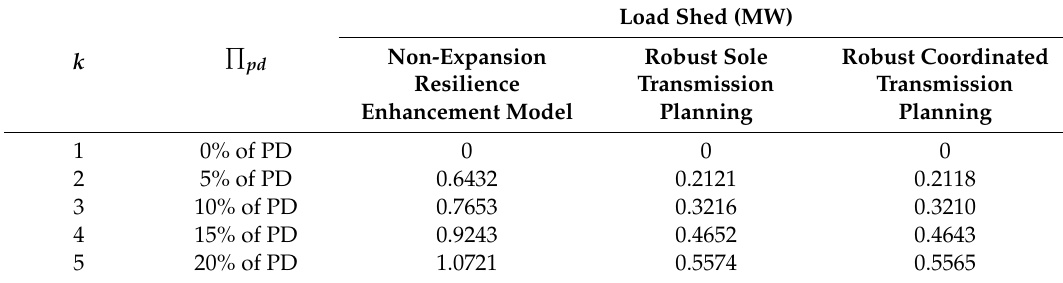
Table 8. Load shed of the IEEE 118-bus power system under di ff erent k ’s.